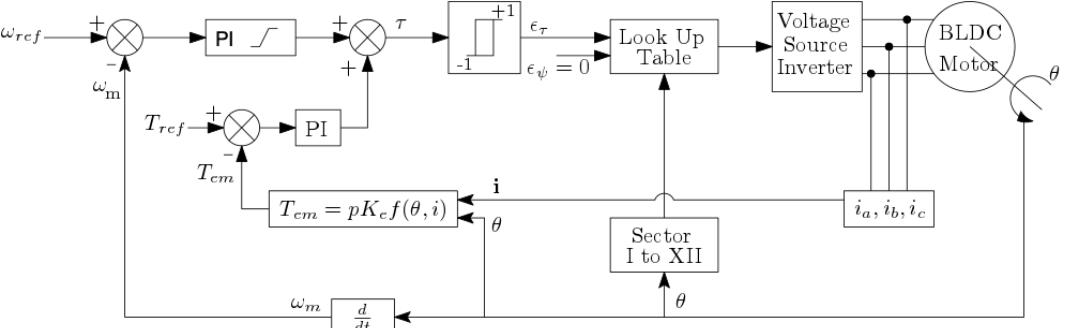
Figure 6. Block diagram of the DTC-2+3P closed loop control proposed in this work.